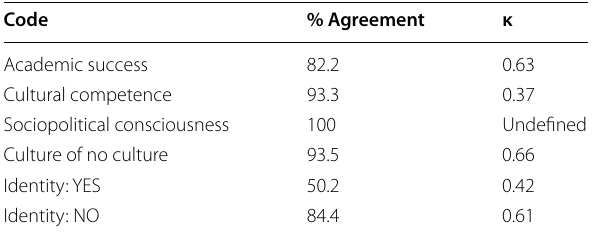
Table 2 Percentage agreement and kappa scores to establish interrater reliability (Cohen,